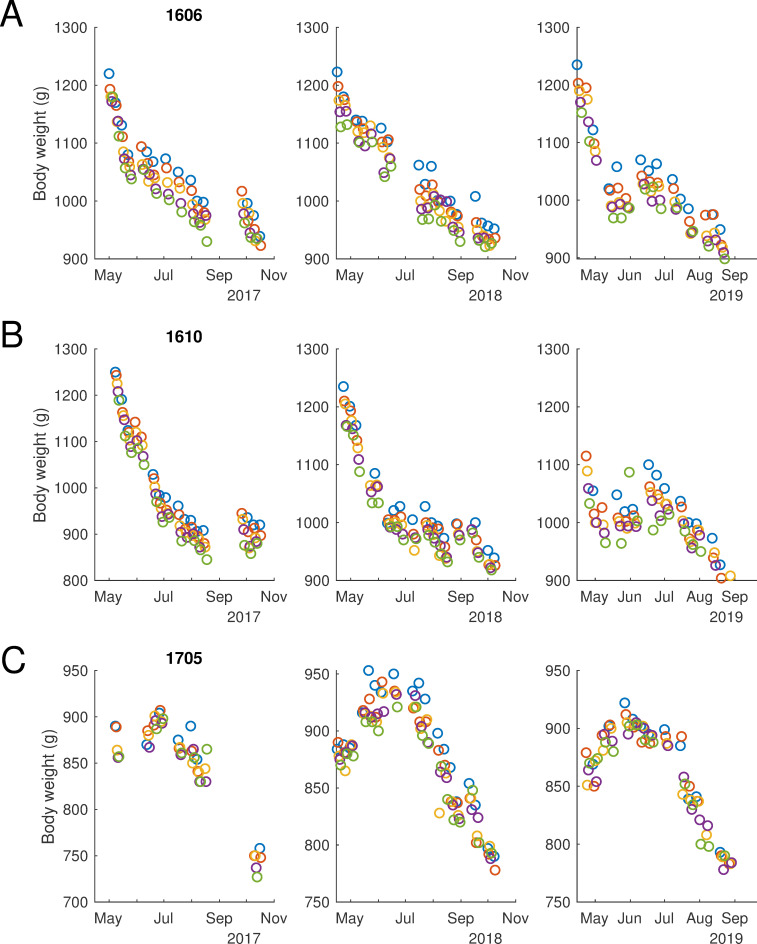
Individuals have distinct but reproduceable weight changes across seasons.Example weight data from three ferrets measured over three consecutive years. Data points recorded are colour coded by day (Monday–Friday: Blue, orange, yellow, purple, green). A, F1606, shows sustained weight loss throughout the summer. B, F1610, shows initial rapid weight loss which stabilises. C, F1705, continues to gain weight after the light change, before beginning to lose weight for the remainder of the season. Patterns A and B were most common, although the pattern evident in C was seen in 5/39 animals.